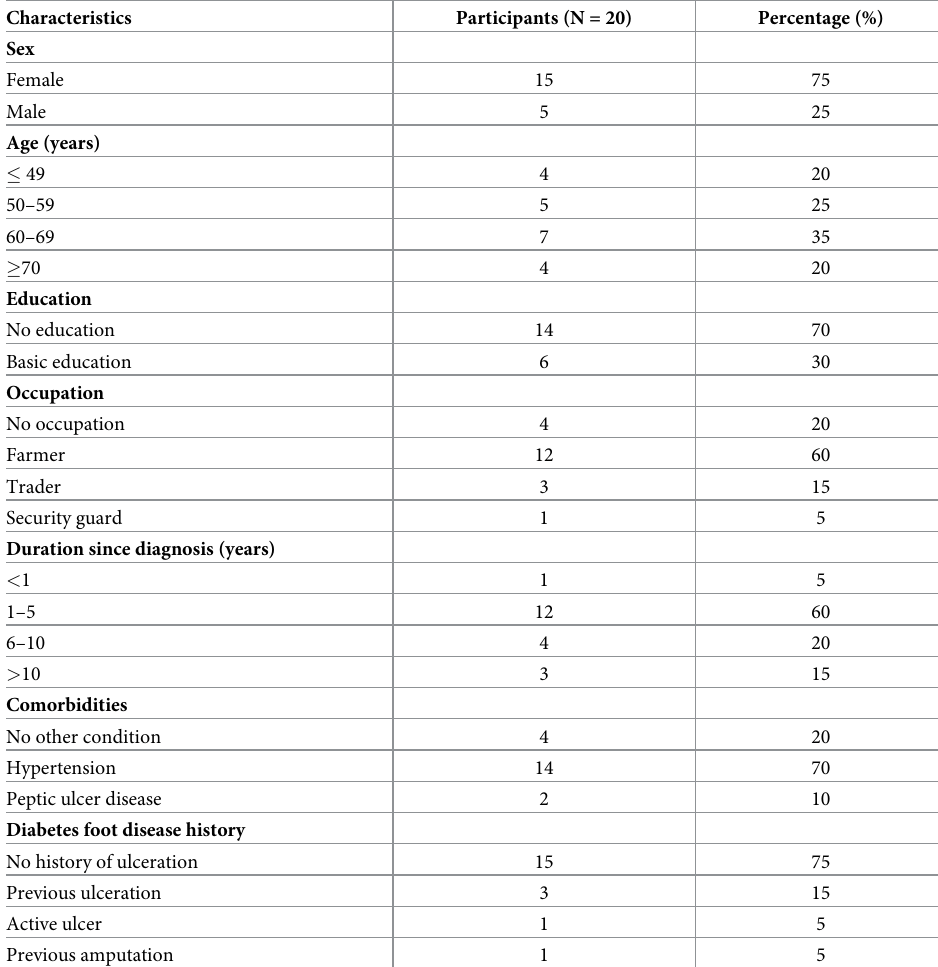
Table 1. Characteristics of participants.